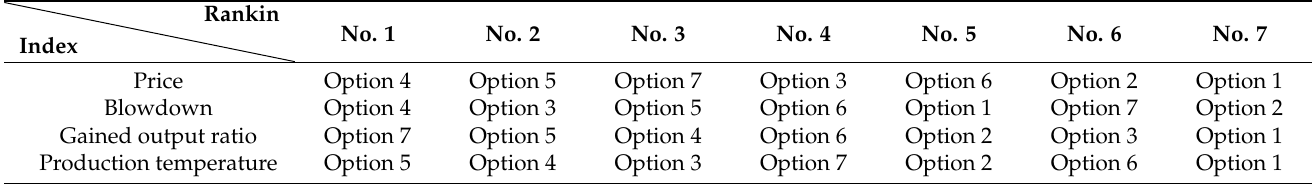
Table 26. Number of variables with